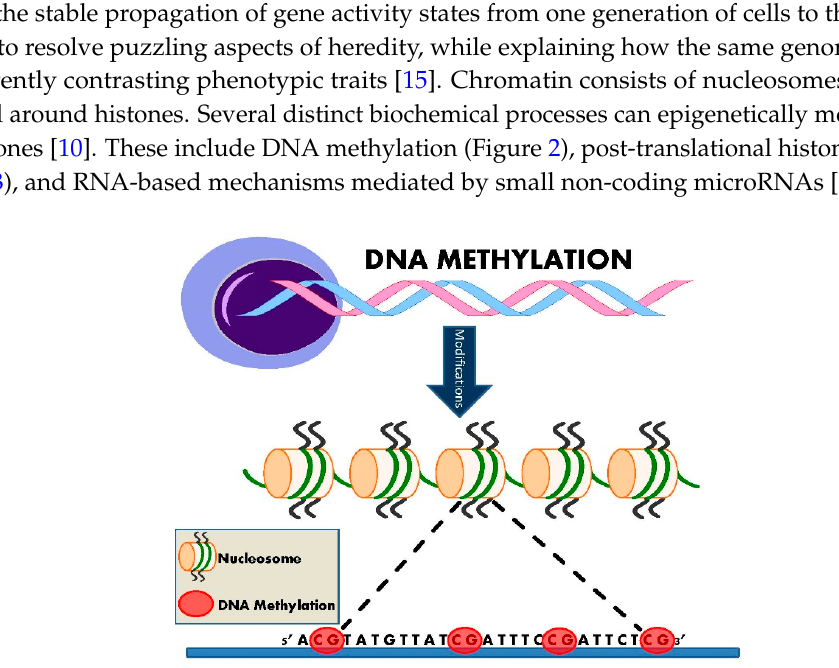
Figure 2. Epigenetic DNA methylation. DNA methylation involves the binding of a methyl group to the 5’ carbon of cytosine ring. This primarily occurs at CpG islands and results in inhibition of gene transcription, particularly if it occurs in the gene promoter region. It may also promote transcription if it is located at gene exons sites. DNA methylation is an essential biological process which is linked with several epigenetic phenomena including X-chromosome inactivation, genomic imprinting and repetitive element